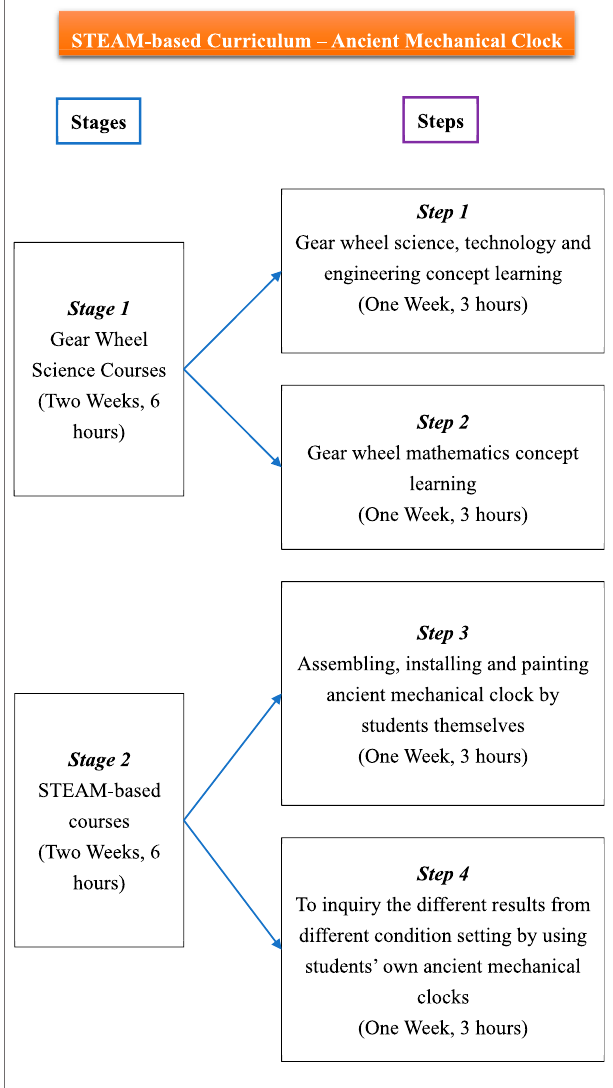
FIGURE 1 | STEAM-based curriculum design about ancient mechanical group ( n (cid:1) 31, 18 males, 13 females; mean age ± SD (cid:1) 14.3 ± 0.5 years). All participants were asked to complete the Scienti fi c Creativity test (Hu and Adey, 2002) before the whole course, after the fi rst stage of the course, and after the second stage of the course. However, the two groups of students went through different stage designs. The curriculum design details will be introduced in the next section.